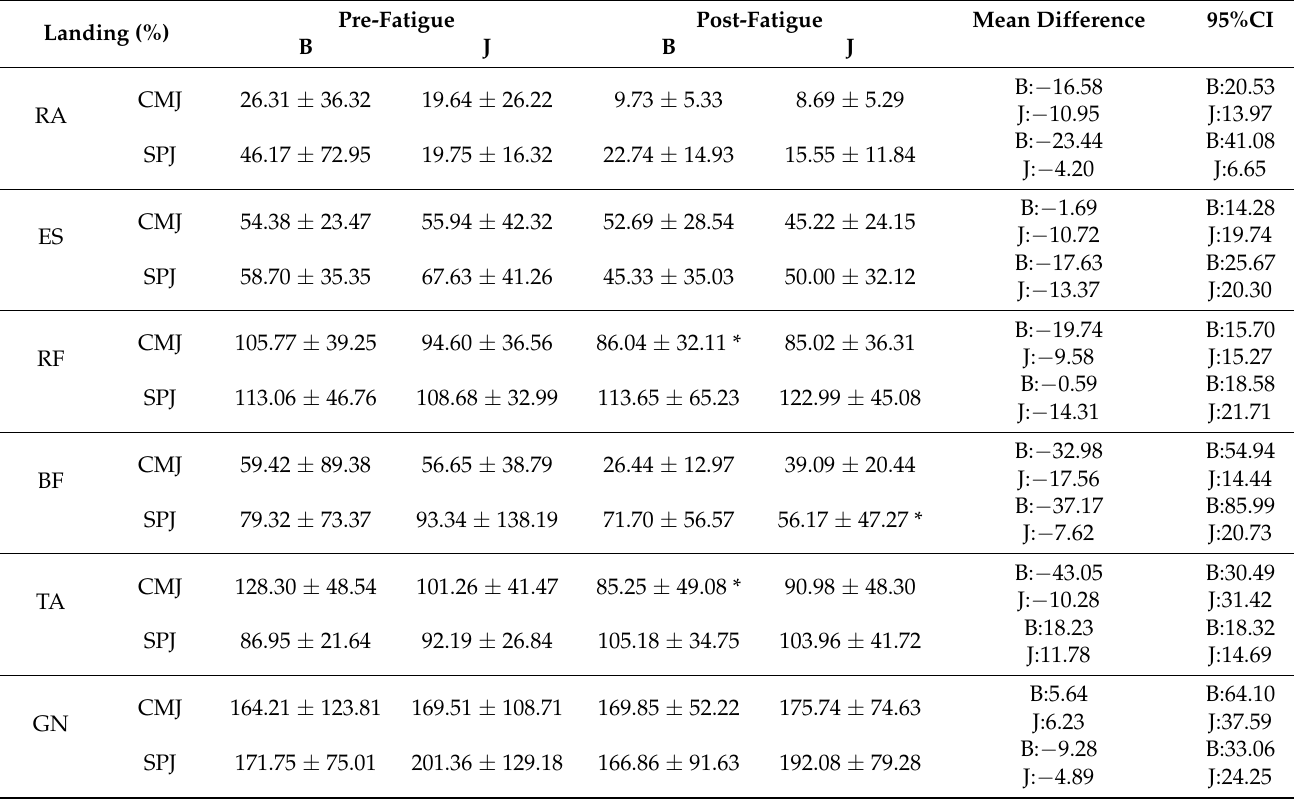
Table 5. Muscle activation at touchdown